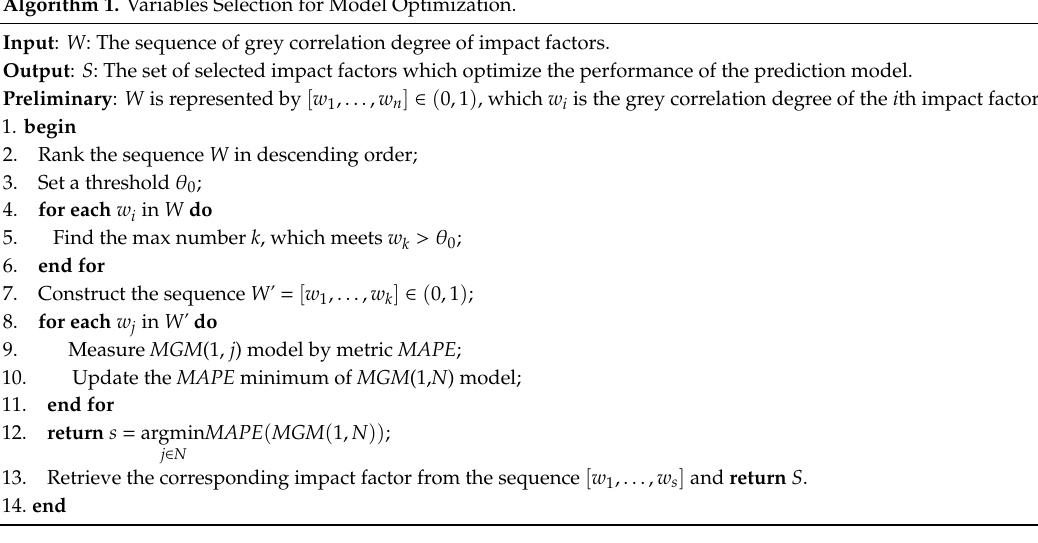
Algorithm 1. Variables Selection for Model